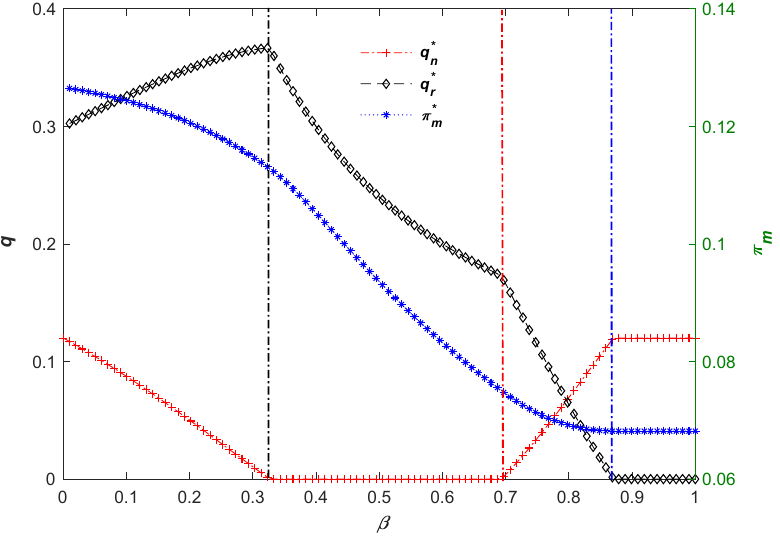
Figure 2. The manufacturer’s decision process and total profit under carbon credit policy.